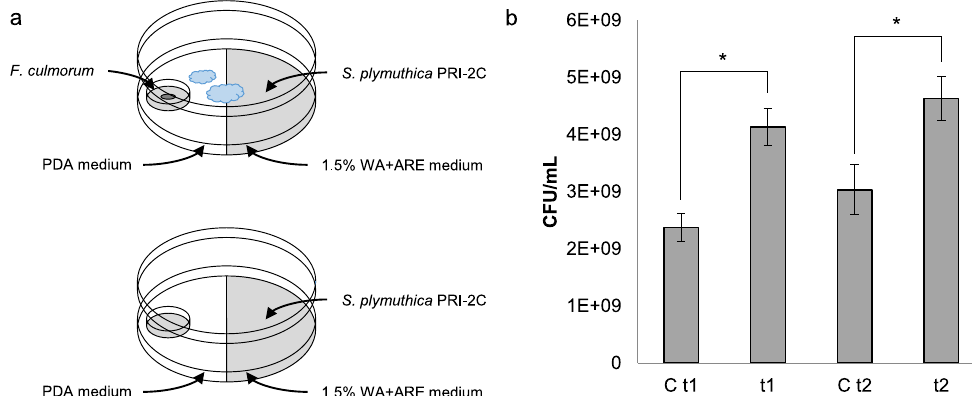
Figure 1. Overview of experimental setup and fungal VOC effect on bacterial growth. Schematic overview of the plate-within-a-plate system ( a ). Growth of S. plymuthica PRI-2C exposed to fungal VOCs after 48 h (t1) and 72 h (t2) ( b ). Controls S. plymuthica PRI-2C without exposure to VOCs after 48 h (C t1) and 72 h (C t2). Error bars represent standard deviations between replicates ( n = 3). Asterisk indicates statistical significance ( p < 0.05) of each time point compared to the respective